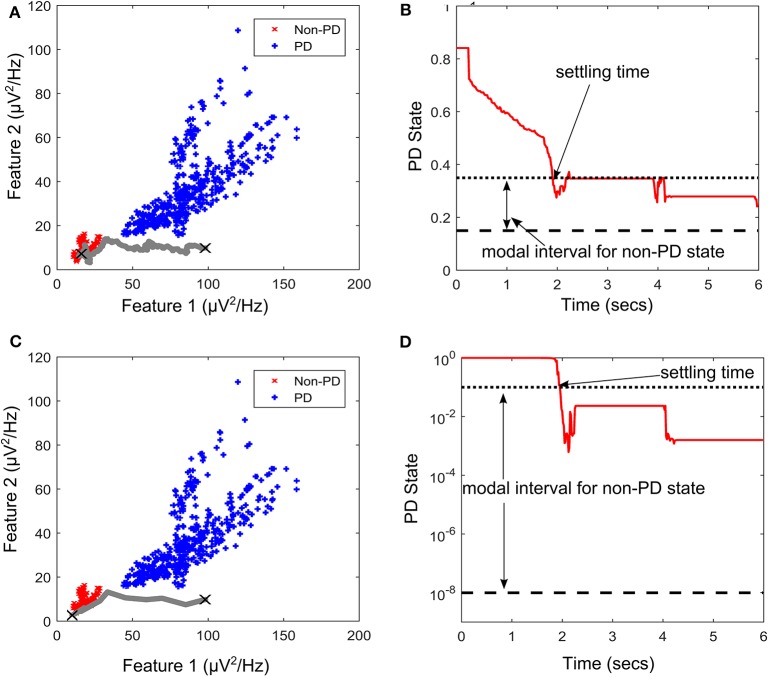
State transition of PD suppression on feature space of patient/dataset E. (A) Showing PD state transition on a feature space using SVM for state estimation, with “X” markers showing start (from PD) and settling (non-PD) positions. The feature space trajectory is indicated in gray. (B) PD state profile for PD suppression using SVM to obtain state estimates. It depicts the modal interval for the non-PD state when SVM is used for state estimation. (C) Showing PD state transition on a feature space using GMM for state estimation, with “X” markers showing start (from PD) and settling (non-PD) positions. The feature space trajectory is indicated in gray. (D) PD state profile for PD suppression using GMM to obtain state estimates. It depicts the modal interval for the non-PD state when GMM is used for state estimation.